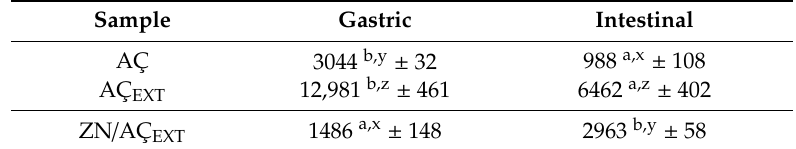
Table 3. Phenolic content as (mg gallic acid per gram) of aça í samples after in vitro digestive processes.